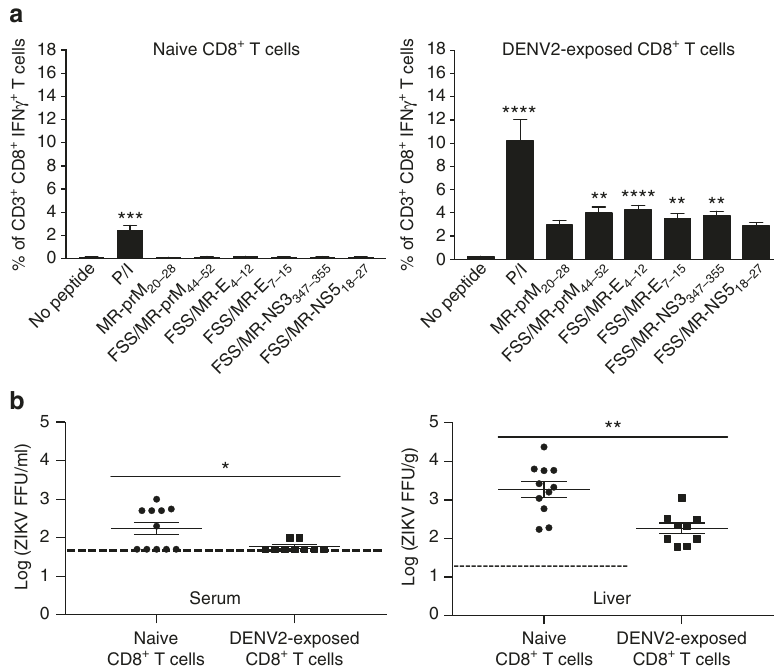
Fig. 4 Reduced ZIKV burden in WT mice adoptively transferred with DENV2-exposed CD8 + T cells. Naive or DENV2-exposed CD8 + T cells (1 × 10 7 ) from WT mice were adoptively transferred to naive recipient WT mice that were intraperitoneally injected with 2 mg of the IFNAR1-blocking mAb MAR1-5A3 1 day before ZIKV challenge. Three days post ZIKV challenge (1 × 10 6 FFU of FSS13025, retro-orbital route), cross-reactive peptide-speci fi c CD8 + T